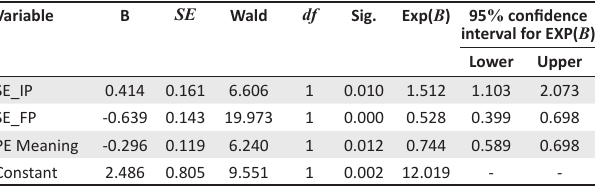
TABLE 3: Logistic regression predicting turnover intention by employee empowerment. Variable